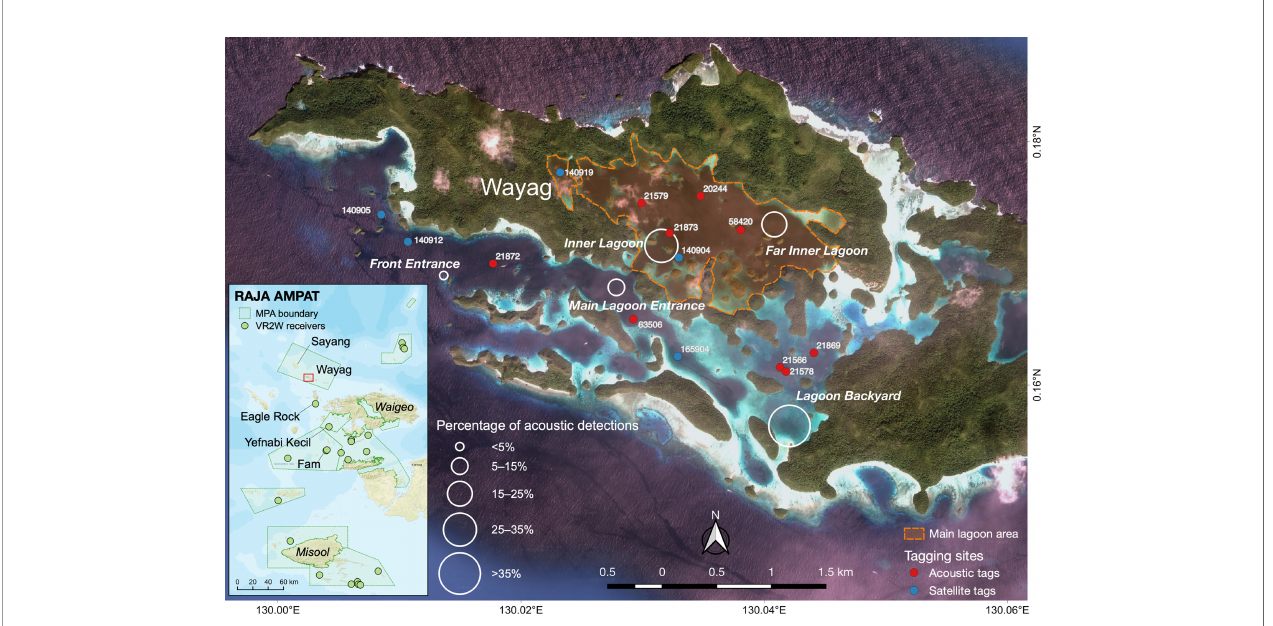
FIGURE 1 | The Raja Ampat, West Papua, Indonesia region (inset) and Wayag lagoon denoted in the red box. Green points on the inset map depict the location of acoustic receivers deployed throughout the Raja Ampat archipelago. White circles on the main map indicate the location of the passive acoustic telemetry array deployed in the study area to monitor juvenile M. alfredi residency and habitat use. The size of circles indicates the proportion of tagged M. alfredi acoustic detections recorded by each receiver throughout the study period. Red and blue points on the main map indicated the deployment locations of all